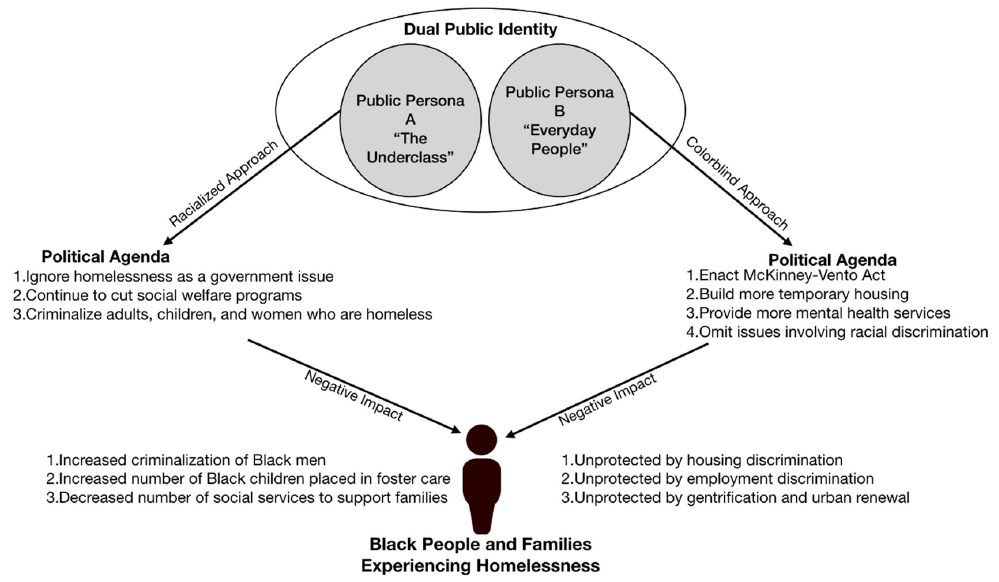
Figure 3. The dual public identity of the homeless .